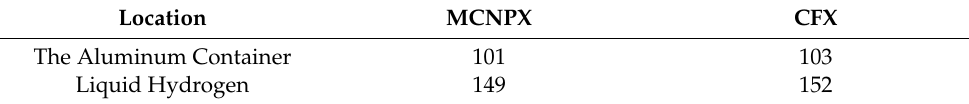
Table 1. Comparison of simulation results between CFX and MCNPX (W).